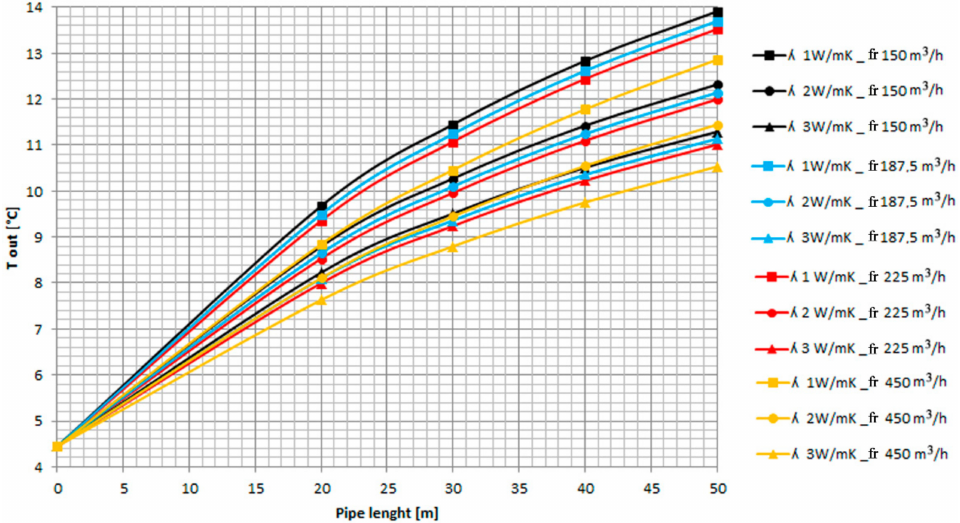
Figure 8. Air temperature along the pipe in the coldest hour (24 December, at hour